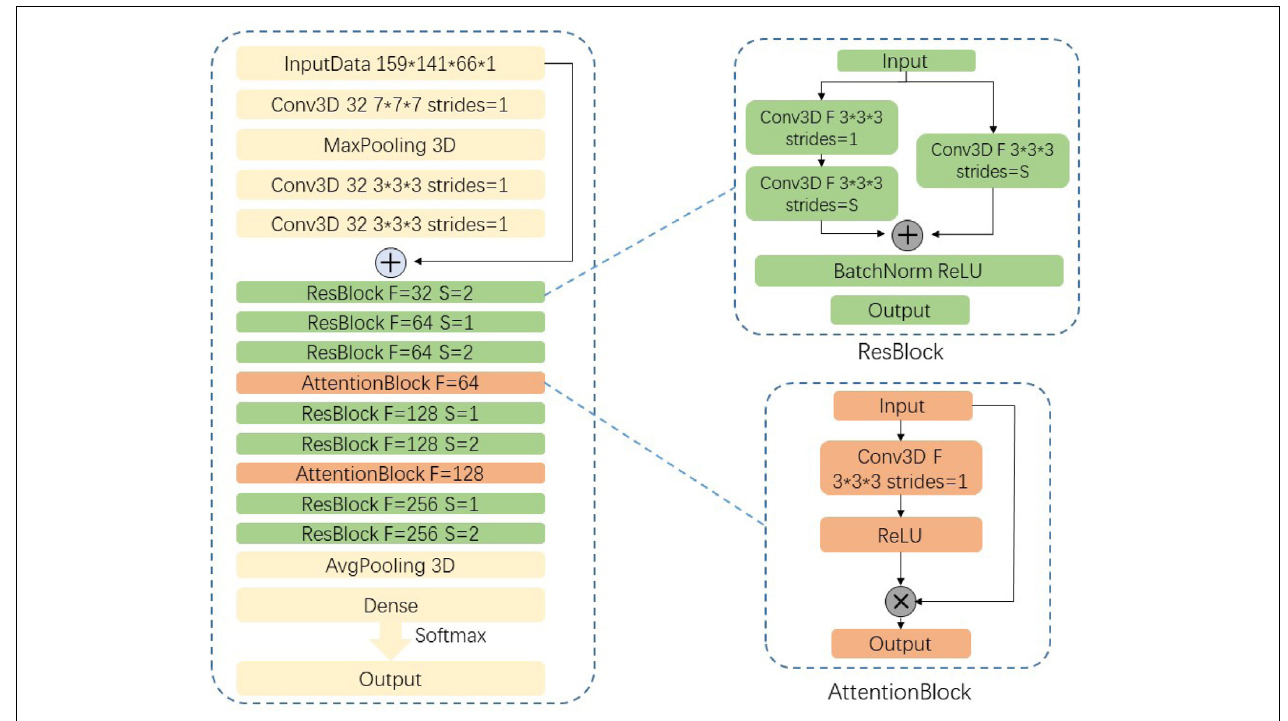
FIGURE 3 | Network